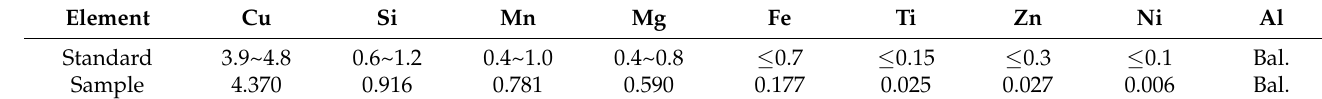
Table 1. Chemical composition of the 2A14 aluminum alloy (wt.%).